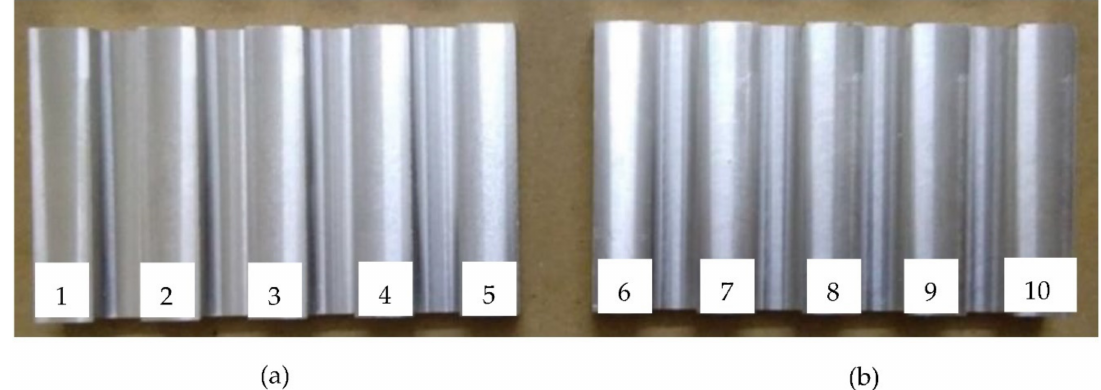
Figure 2. ( a ) Sample 1 and ( b ) sample 2 with surface numbering.